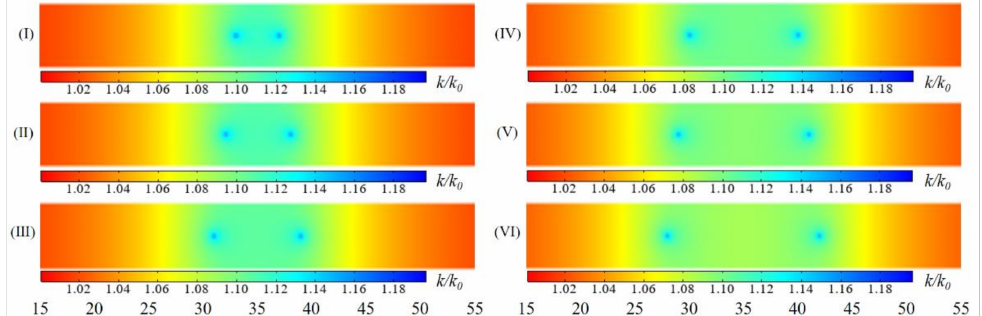
Figure 21. Cloud chart of permeability distribution around boreholes with different spacing: ( I ) 4 m;